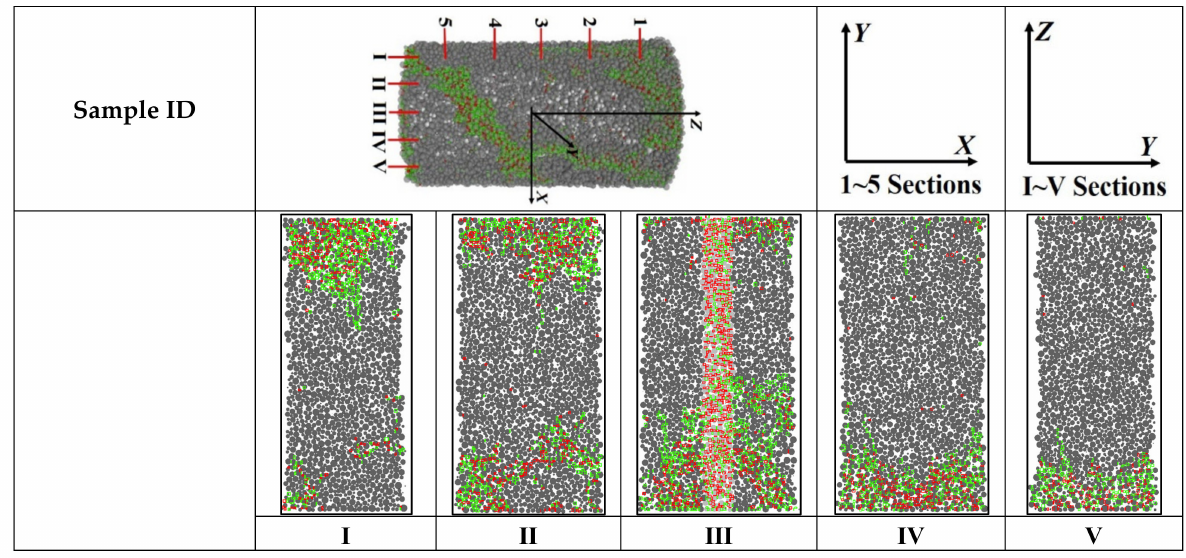
Figure 15. Temporal and spatial evolution of a crack: ( a ) RBCM-10; ( b ) RBCM-30. In order to study the spatial distribution of the internal cracks of the RBCM after compression failure, 10 sections were selected for the numerical model after RBCM model failure, and the results are shown in Figure 16.